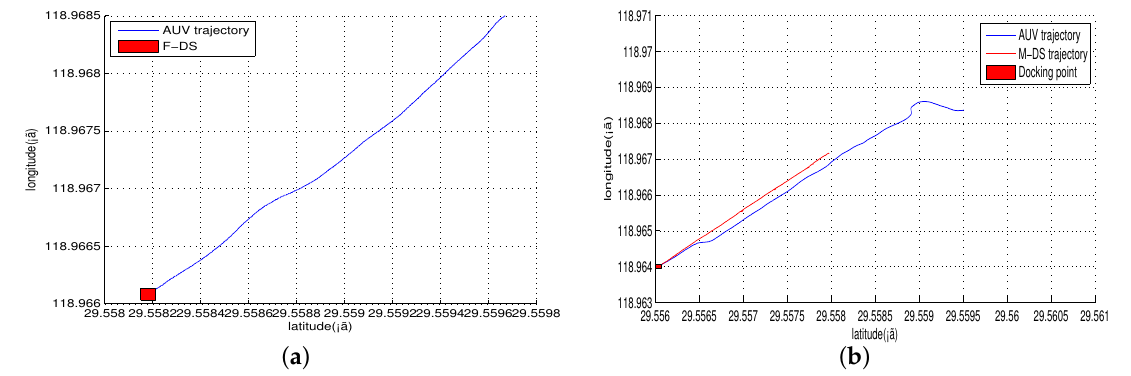
Figure 17. ( a ) Trajectory of AUV recorded by IMU in AUV homing to the F-DS. ( b ) Trajectories of AUV and mobile docking station (M-DS) recorded by IMU in AUV homing to M-DS.